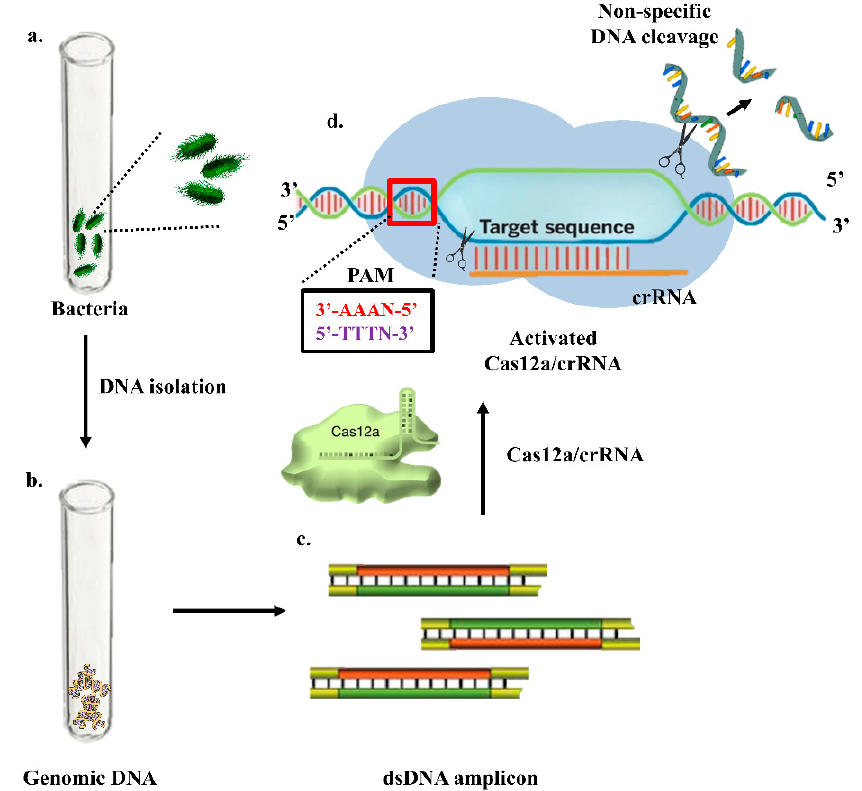
Figure 8. CRISPR based detection of Salmonella . ( a ) Bacterial culture; ( b ) Bacterial genomic DNA isolation; ( c ) dsDNA amplicon generation; ( d ) Binding of Cas12-crRNA complex with target DNA leading to trans-cleavage activity.